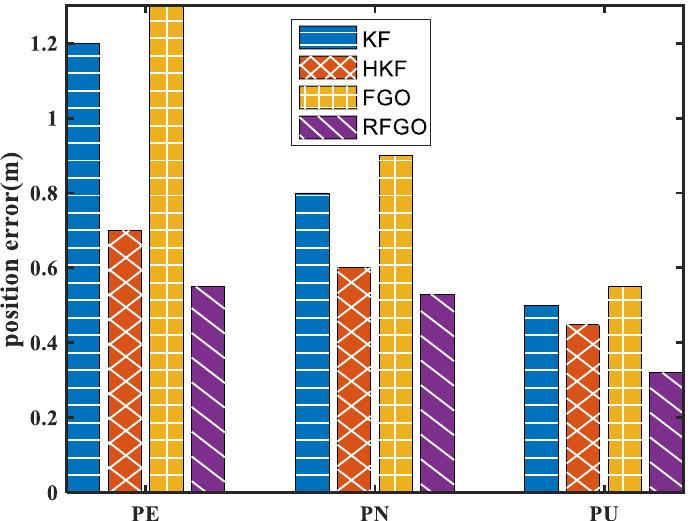
Figure 5. Position error of different algorithms in Monte Carlo simulation.